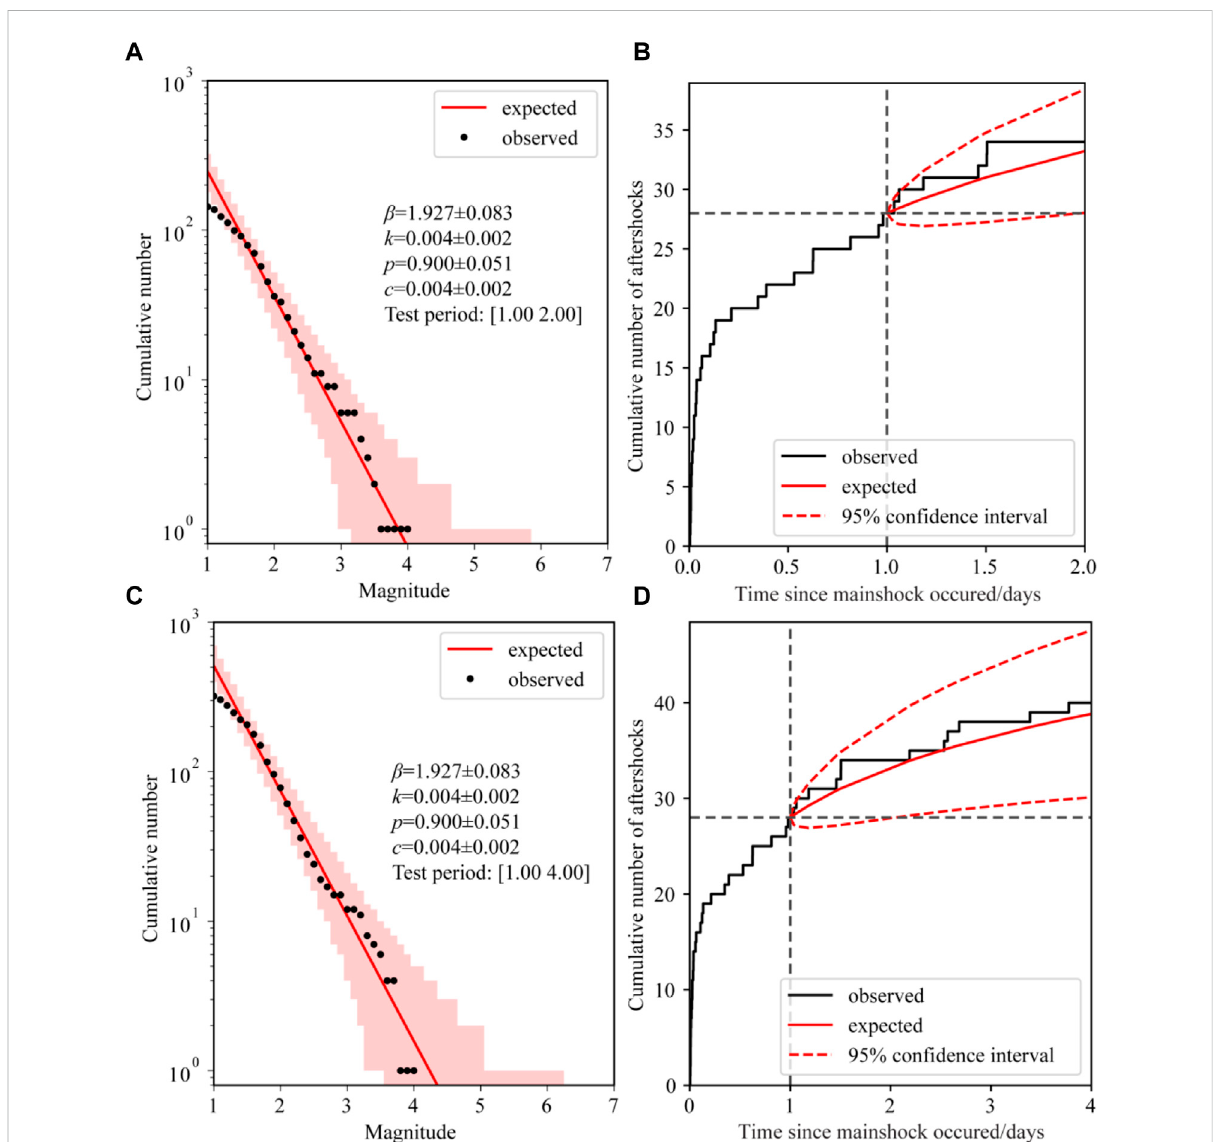
FIGURE 2 Future 1-day and 3-day aftershock forecasting for the Menyuan M S 6.9 earthquake sequence using the Omi-R-J model. (A,B) Time period of 1.00 – 2.00 days and (C,D) time period of 1.00 – 4.00 days after the main shock. (A,C) Comparison of magnitude – cumulative frequency between forecasting (red lines) and actual observed aftershocks (black dots) and their 95% con fi dence intervals (pink areas). (B,D) Comparison of magnitude – cumulative frequency between forecasting (red curves) and actual observed aftershocks (black curves) of M > 2.95 and their 95% con fi dence intervals (red dashed lines), and the forecasting starting and ending times (black vertical dashed lines) are